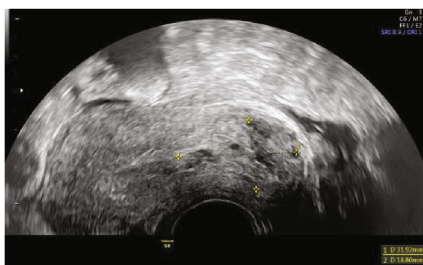
Figure 1: Transvaginal ultrasonographic study of the pelvic- abdomen region shows a retroverted uterus with a biometry of 70mm x 40mm. The uterine morphology was regular, and the myometrial ultrasound pattern was homogeneous. The endometrial thickness was 7mm. The cervical canal was occupied by abundant blood content and clots with a size of 34mm.